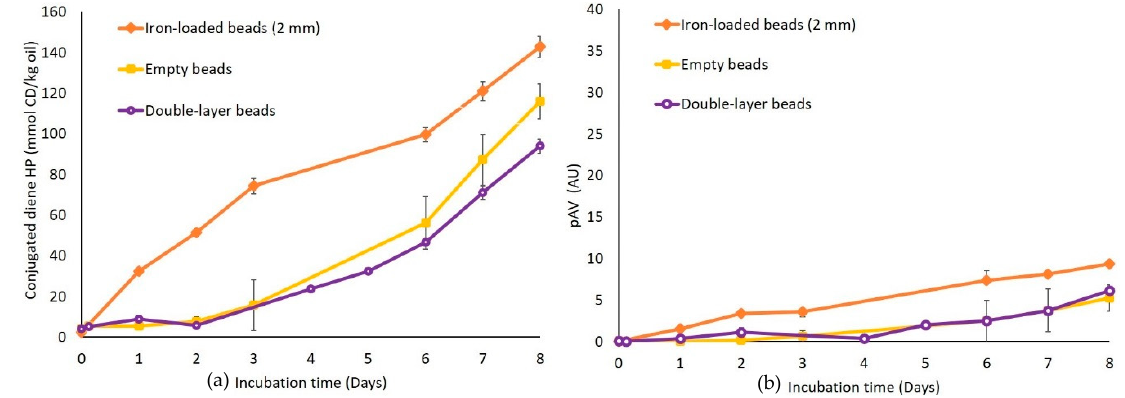
Figure 6. ( a ) Conjugated diene (CD) hydroperoxide ( b ) and para-anisidine values (pAV) in O / W emulsions with iron-loaded alginate beads ( ● ), empty alginate beads ( ■ ), and double-layer alginate beads ( ). All emulsions were incubated at 25 ◦ C under slow rotative agitation. For the two emulsions containing iron, the FeSO 4 concentration was 200 µM. Error bars represent standard deviations (n = 4).